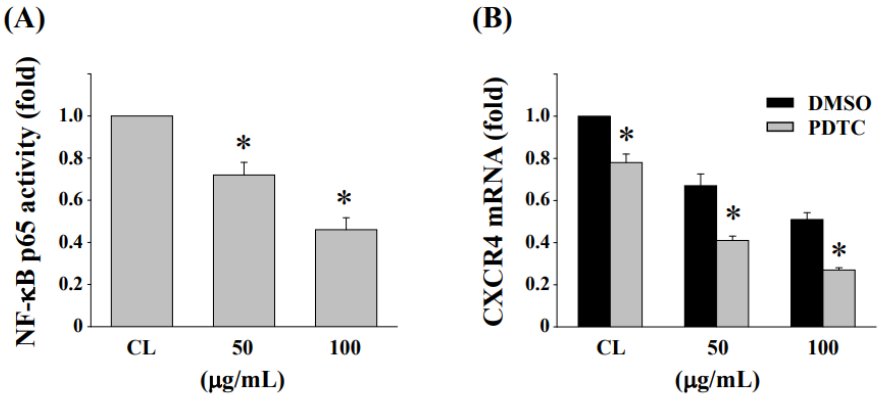
and ( B ) trypan blue exclusion assay. The results (mean ± standard error of the mean) were from three independent experiments. * p < 0.05 vs. si-CL-transfected cells.